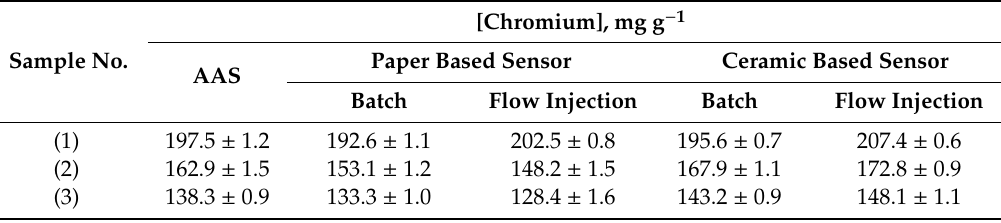
Table 3. Potentiometric determination of chromium in some nickel-chrome heating wires and alloys using paper and ceramic-based chromium (VI) sensors with PANI solid contact.